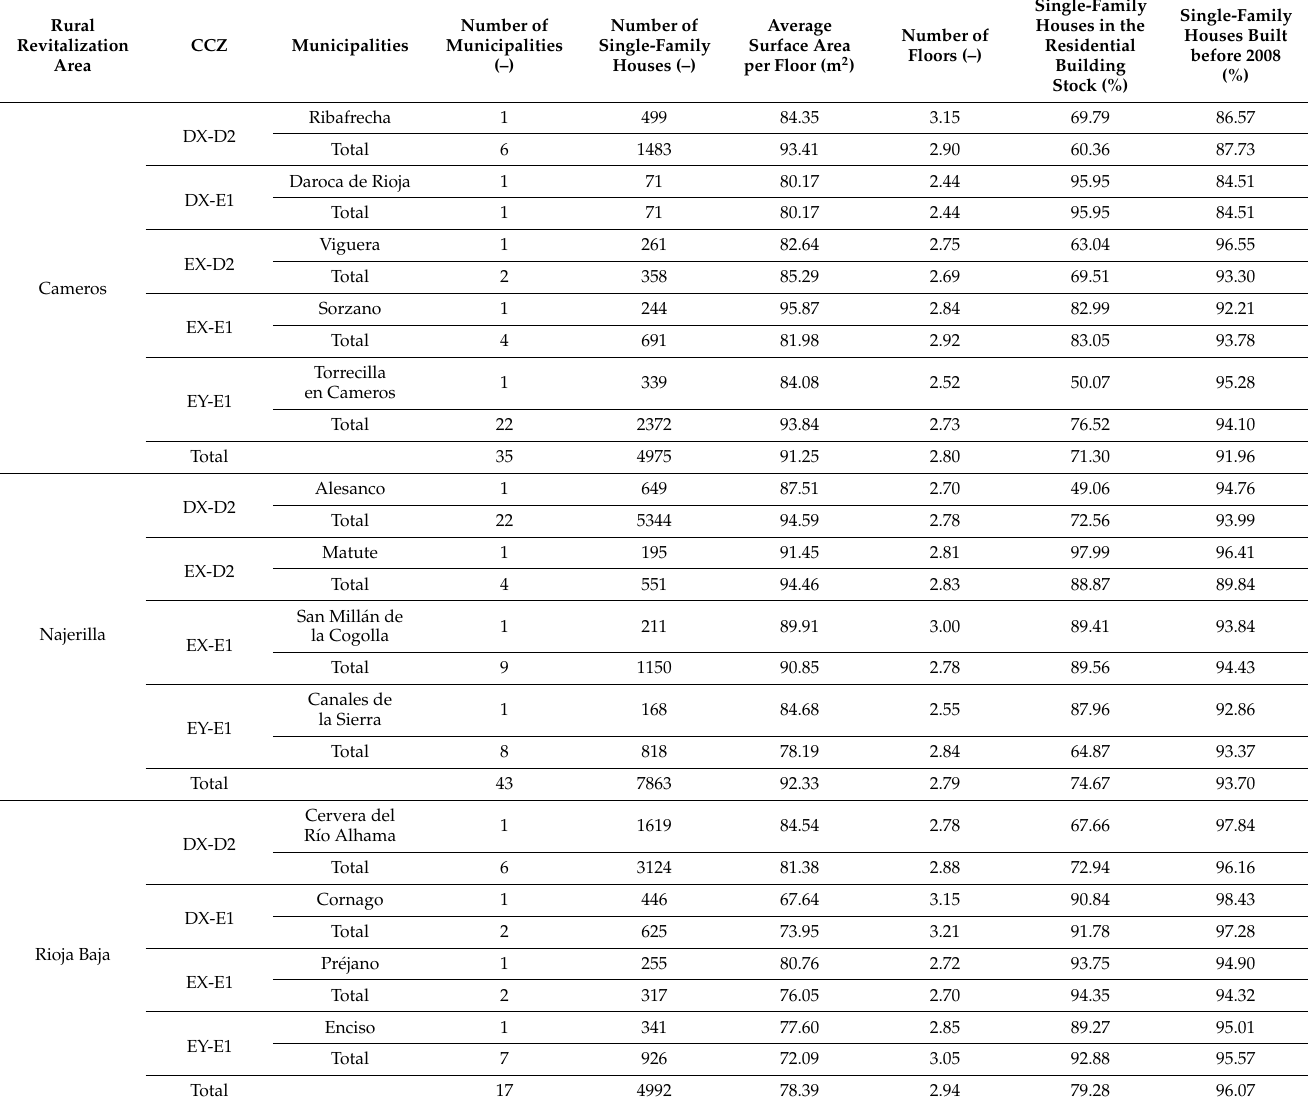
Table 2. Main characteristics of the single-family houses in the residential building stock in rural revitalization areas, by rural revitalization area and CCZ, highlighting those municipalities with the greatest number of single-family